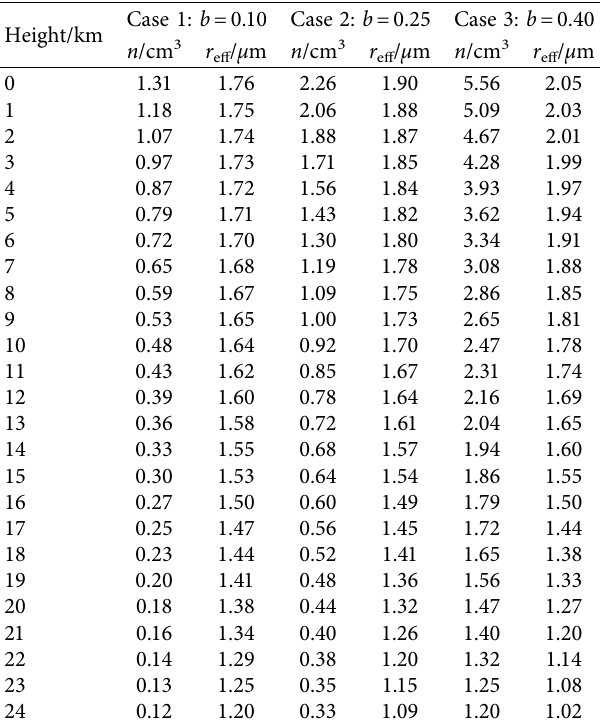
Table 2: The vertical distribution of the number concentration and effective radius of Martian dust particles corresponding to the three models [17, 18]. Case 1: b � 0.10 Case 2: b � 0.25 Case 3: b � Height/km